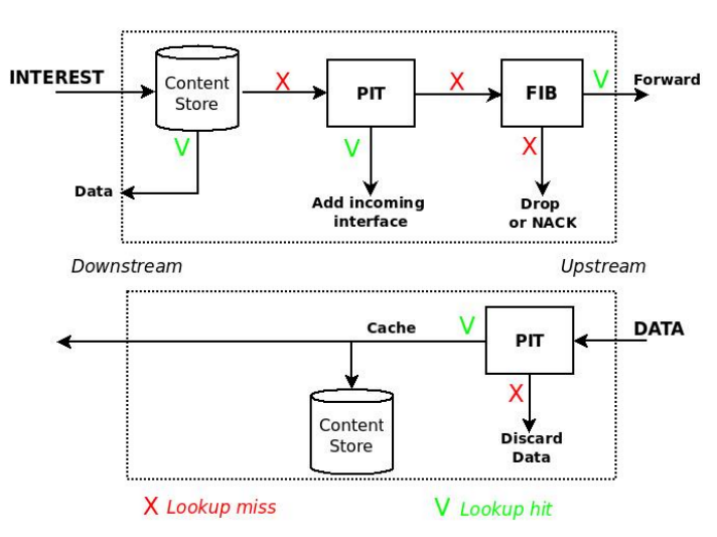
Figure 1. Forwarding Process in